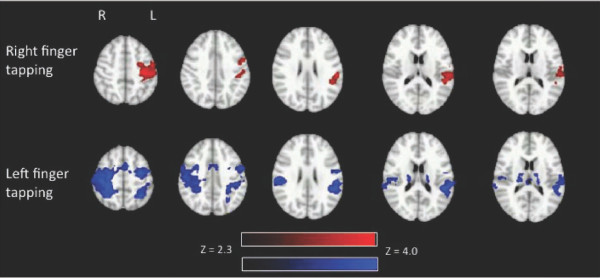
Group activation (N = 10) in white and gray matter during right finger tapping (above) and left finger tapping (below). Activation related to right finger tapping is displayed in red and activation related to left finger tapping is displayed in blue. Activation is present in the left primary motor cortex during right finger tapping. Activation is present in the right and left posterior limb of the internal capsule and right primary motor cortex during left finger tapping. Activation is displayed with a Z threshold of 2.3.